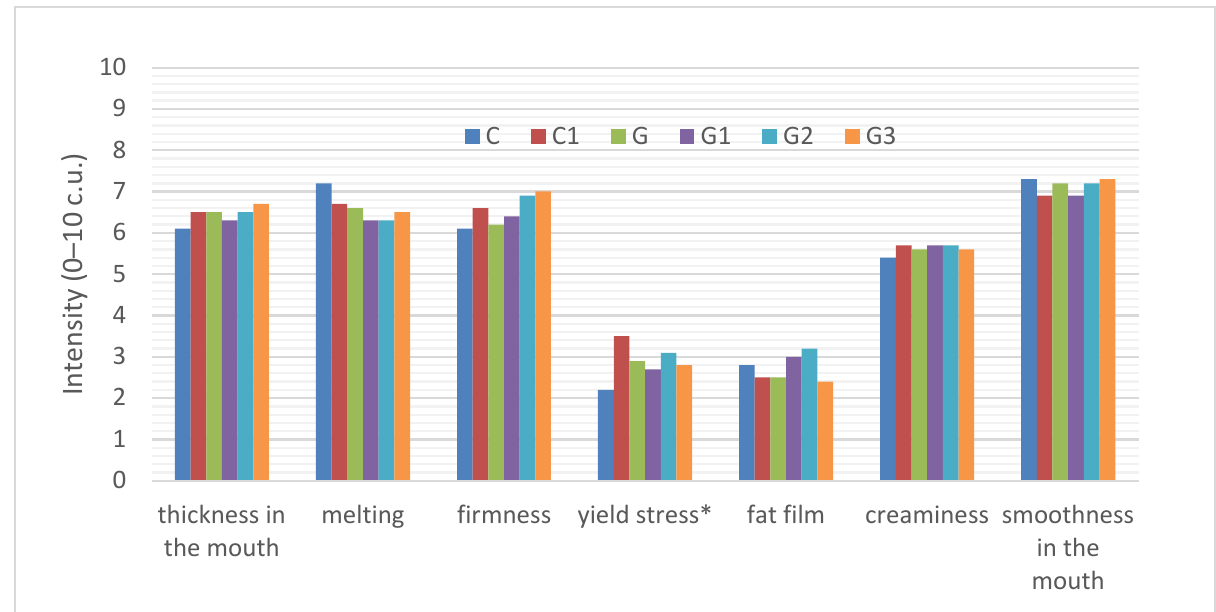
Figure 3. Sensory profile of the consistency of yoghurts C, C1, G, G1, G2. The abbreviations in the figure refer to the control sample (C), control yoghurt with 6% inulin (C1), yoghurt with green tea (G), yoghurt with green tea and 3% inulin (G1), yoghurt with green tea and 6% inulin (G2), yoghurt